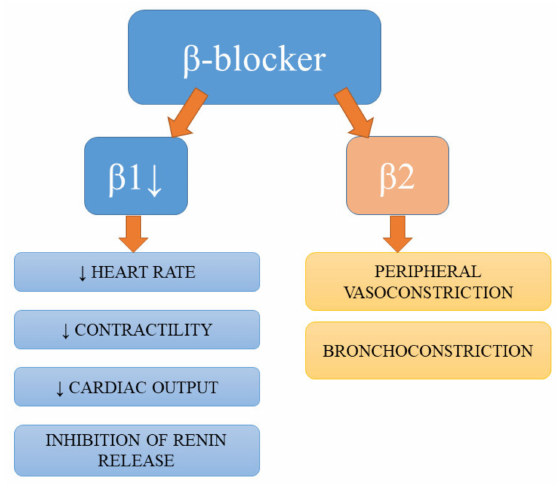
Figure 3. E ff ects of action of β